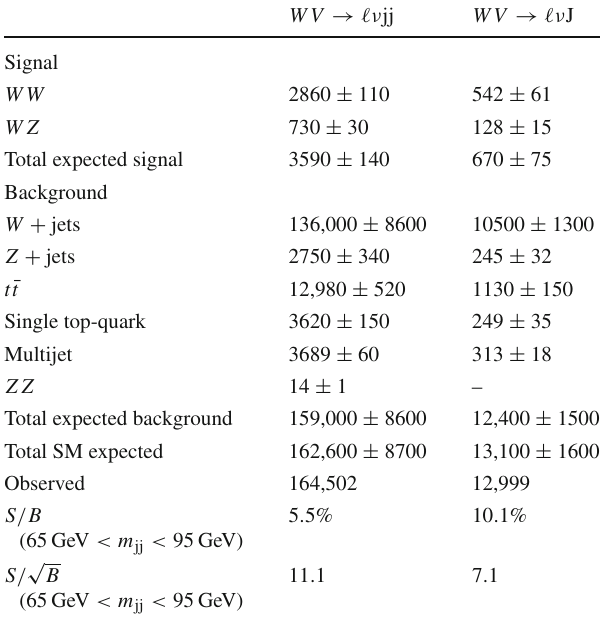
Table 1 Expected number of signal and background events in the WV → (cid:4)ν jj and WV → (cid:4)ν J signal regions, prior to performing the m jj and m J fits. The quoted uncertainties only include detector-related uncertainties and statistical uncertainties of the MC samples and con- trol regions. The number of events observed in data is also shown. The signal predictions only correspond to qq (cid:4) -initiated WV production WV → (cid:4)ν jj